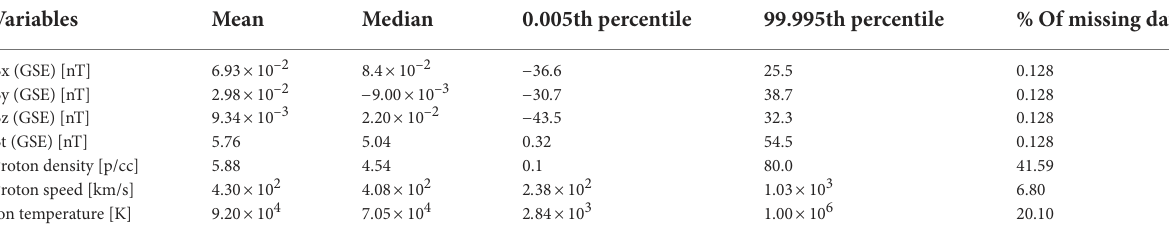
TABLE 1 Mean,median,0.005 th and99.995 th percentilefromACEMAGandSWEPAMdata. Variables Mean Median 0.005th percentile 99.995th percentile % Of missing data